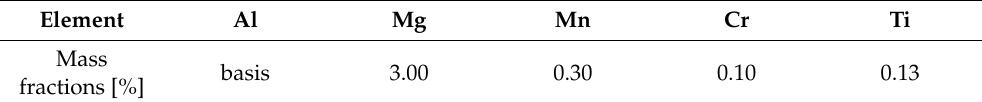
Table 3. Composition of the welding wire AlMg3 [33].